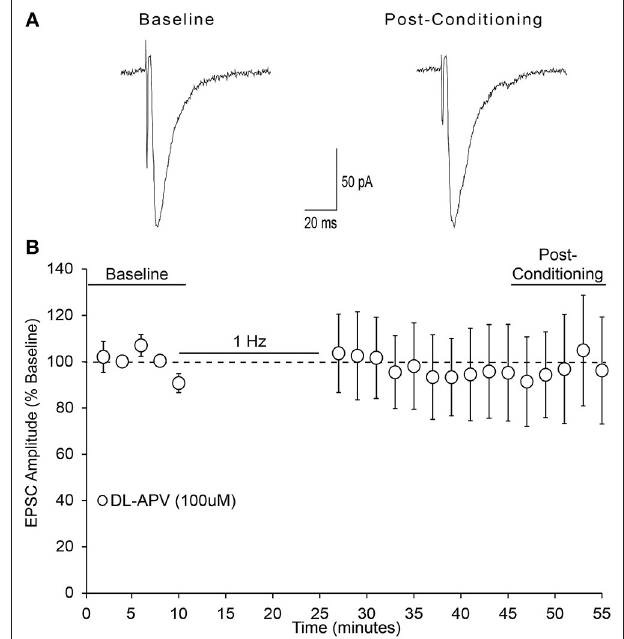
FIGURE 7 | NMDA receptors are required for AIC layer 2/3 pyramidal neuron LTD expression. (A) Representative traces from a single neuron showing evoked EPSCs before and 20–30min after low-frequency conditioning stimulation protocol in the presence of the non-selective NMDA receptor antagonist DL-APV (100 µ M). (B) Conditioning stimulation did not induce LTD expression in the presence of DL-APV (100 µ M), (7 neurons/7 slices/6 mice, p > 0.05 vs. baseline). Values are expressed as averages ±